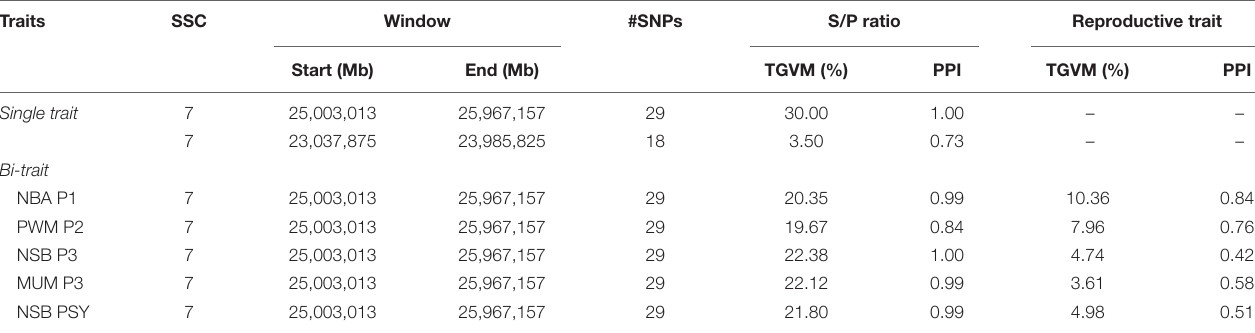
TABLE 3 | Results for the genome-wide association study (GWAS) analysis for sample-to-positive (S/P) ratio (single trait) to porcine reproductive and respiratory syndrome virus vaccination measure as and bi-trait for S/P ratio and reproductive performance. Traits SSC Window #SNPs S/P ratio Reproductive trait Start (Mb) End (Mb) TGVM (%) PPI TGVM (%) Single